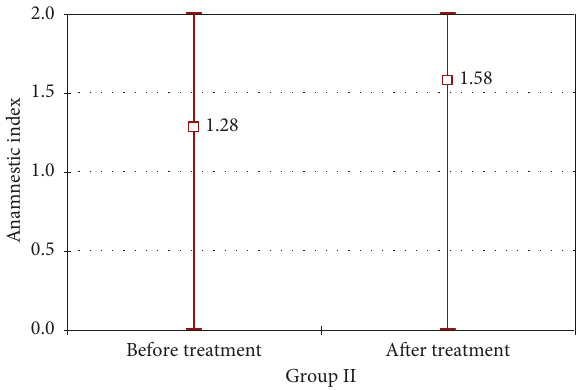
Figure 9: Average, minimal, and maximal values of AI index in group II before and after the prosthodontic therapy.